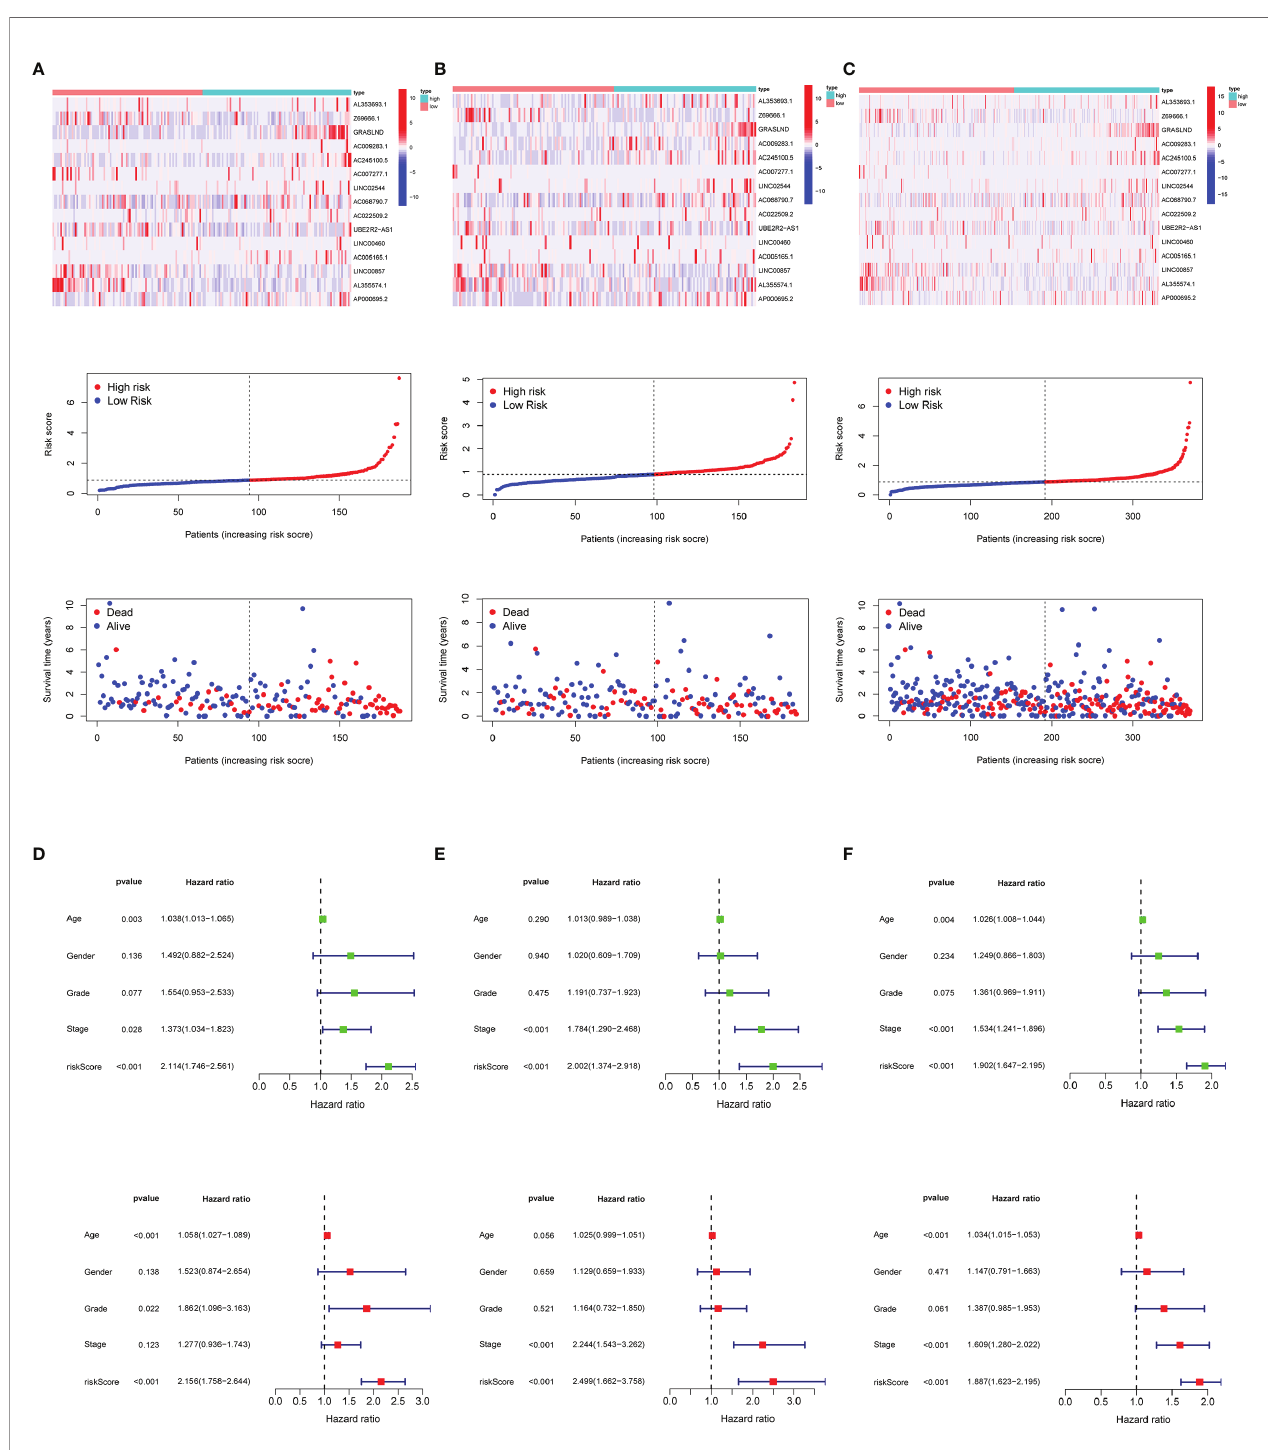
FIGURE 5 | Risk score distribution, survival status, and 15 matrisomal-related lncRNA expression. (A) Training set. (B) Validation set. (C) Total set. Risk score function as an independent prognostic factor. (D) Training set. (E) Validation set. (F) Total